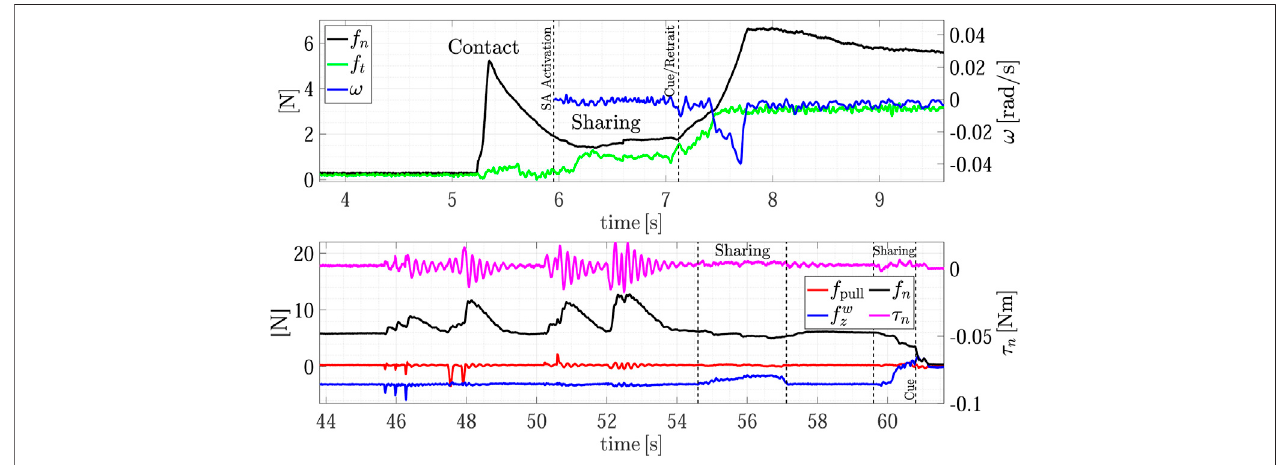
FIGURE 8 | First experiment (Object A): detail of the H2R physical handover phase (top) ; detail of the R2H physical handover phase (bottom) .